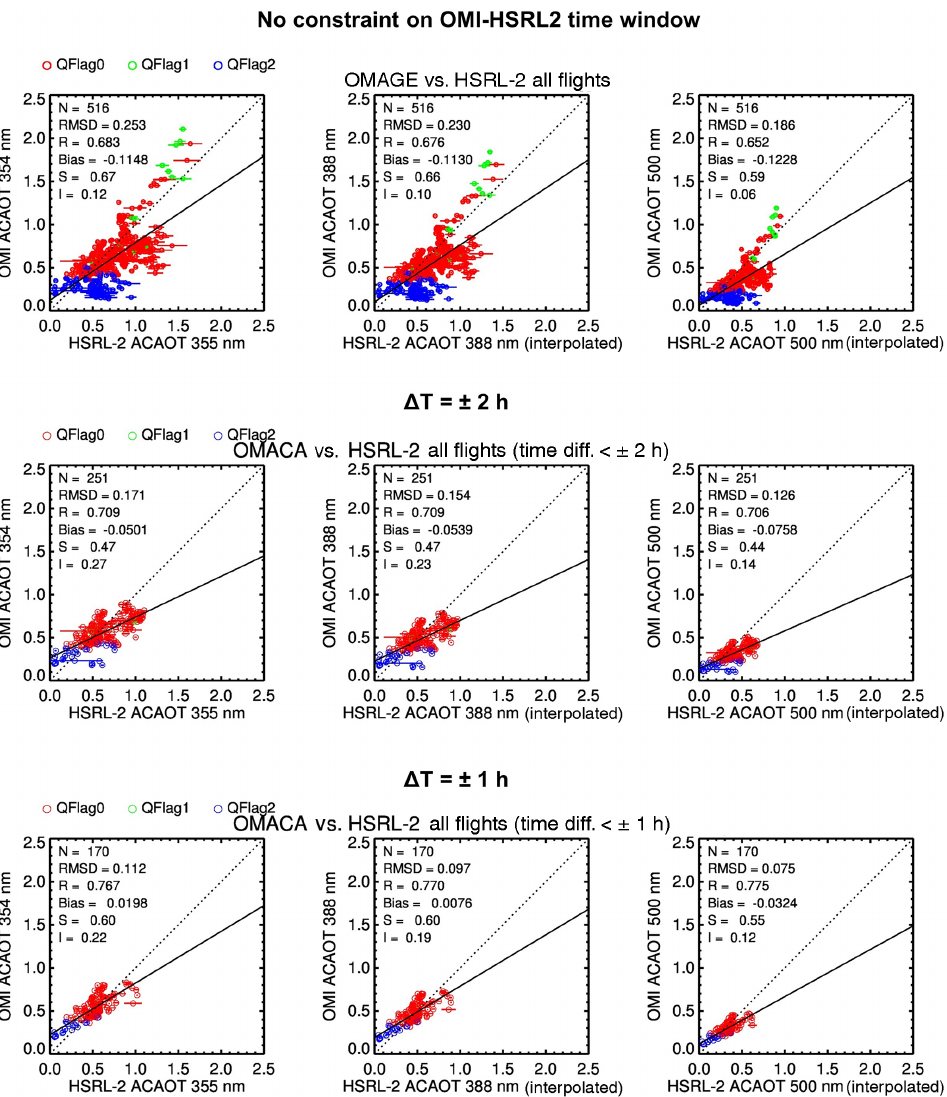
Figure 4. Comparison of coincident and collocated spectral ACAODs measured and retrieved from HSRL-2 and OMI/OMACA for a total of seven ER-2 flights operated during ORACLES phase I operation over the southeastern Atlantic Ocean in August–September 2016. (cid:49)T represents the absolute time difference (in hours) between the OMI overpass and HSRL-2